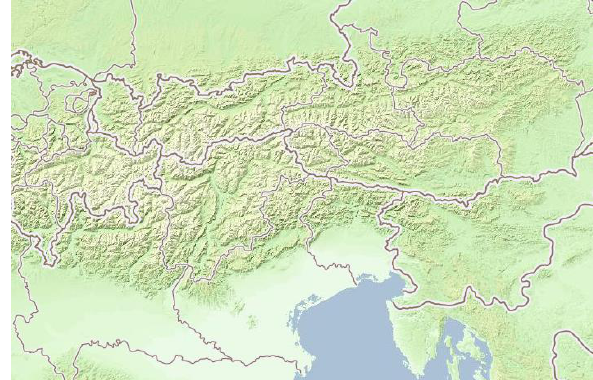
Figure9. Effect of hypsometric tint for details